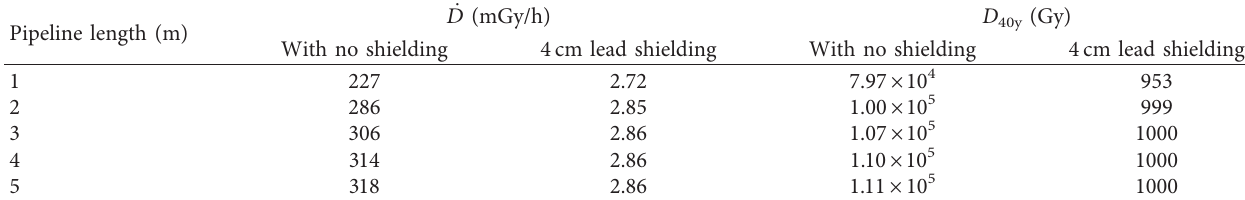
Table 2: _ D and D � 30 cm for 1–5m pipelines for the spent fuel source term. 40y at Dpi Pipeline length (m)